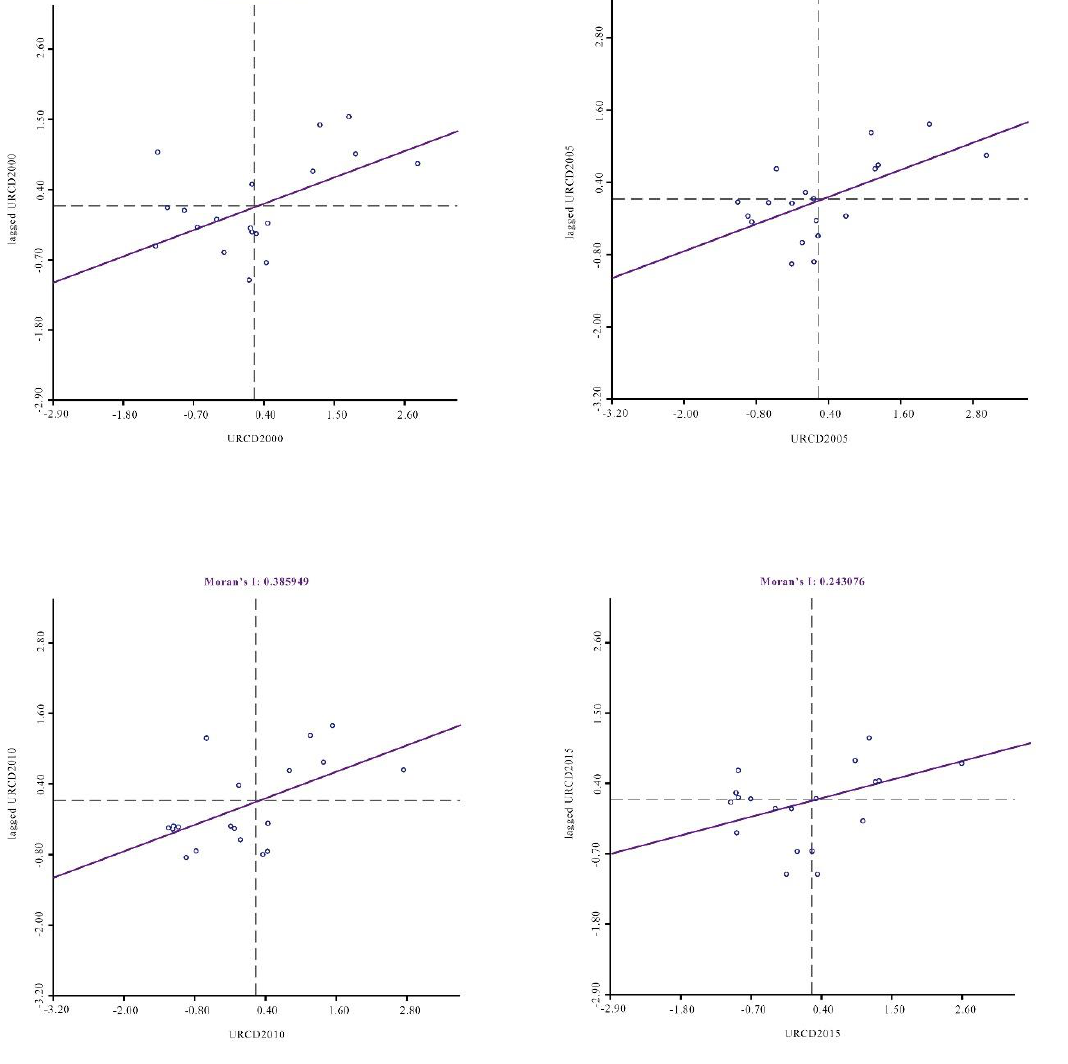
Figure 2. Moran’s I value and Moran scatter diagrams of the comprehensive level of urban and rural coordination